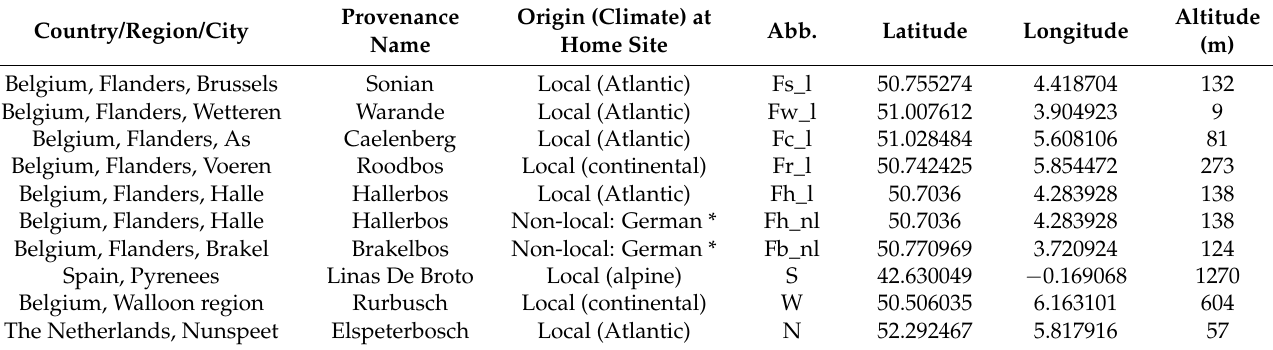
Table 1. Description of the sampled beech provenances. Abb.: abbreviation with l = local (autochthonous) and nl = non-local (non-autochthonous) at the home site.